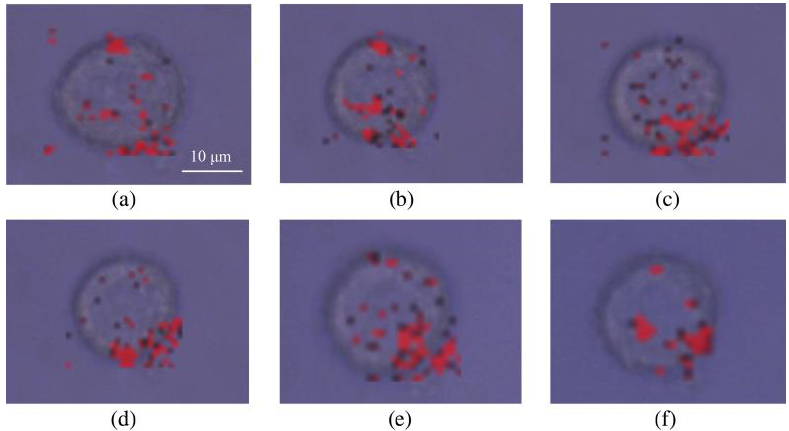
Figure 4. Dynamic imaging of transferrin receptor (TfR) molecules on a single HeLa cell at ( a ) 0 min, ( b ) 10 min, ( c ) 20 min, ( d ) 30 min, ( e ) 40 min, and ( f ) 50 min.